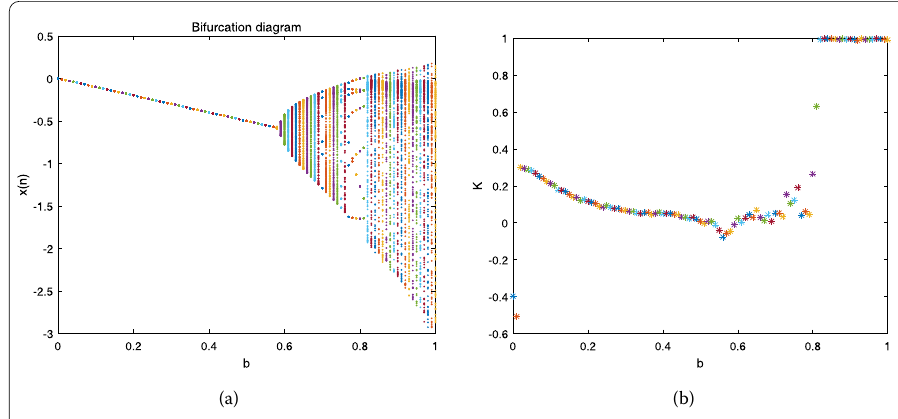
Figure 2 Bifurcation diagram and K median value. The bifurcation diagram ( a ) and K median value ( b ) of system (10) with a = 1, v = 0.9 versus parameter b